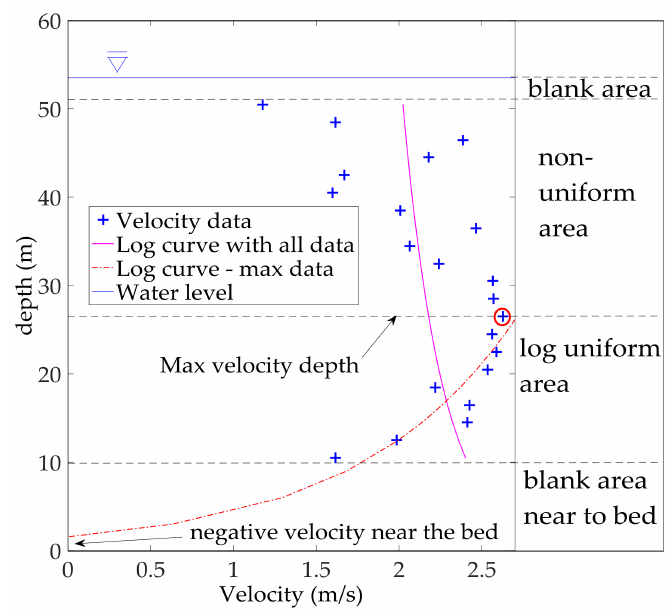
Figure 4. Measured vertical velocity profile of longitudinal velocity (+), and fitted logarithmic curves using a different number of measured